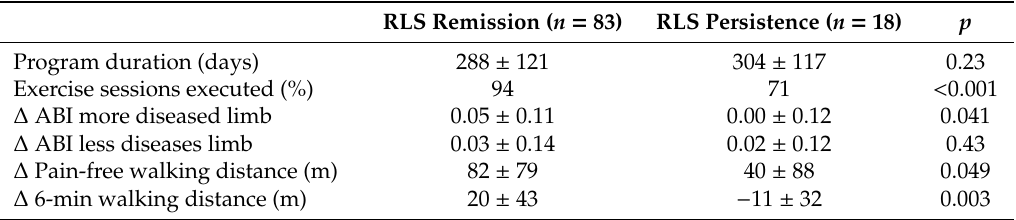
Table 3. Outcomes of the exercise program within restless leg syndrome (RLS) + group of patients who either did or did not exhibit RLS